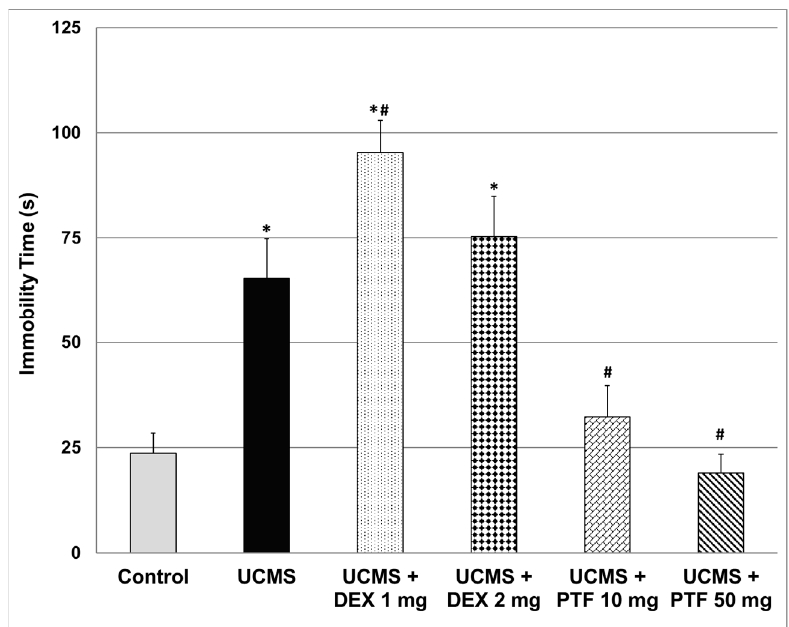
Figure 1. Effects of DEX and PTF on immobility time. Values are mean ± SEM of 11–12 rats in each group. One-way ANOVA test: F = 23.5, p < 0.0001; t -test: * p < 0.05 vs. control, # p < 0.05 vs. UCMS.